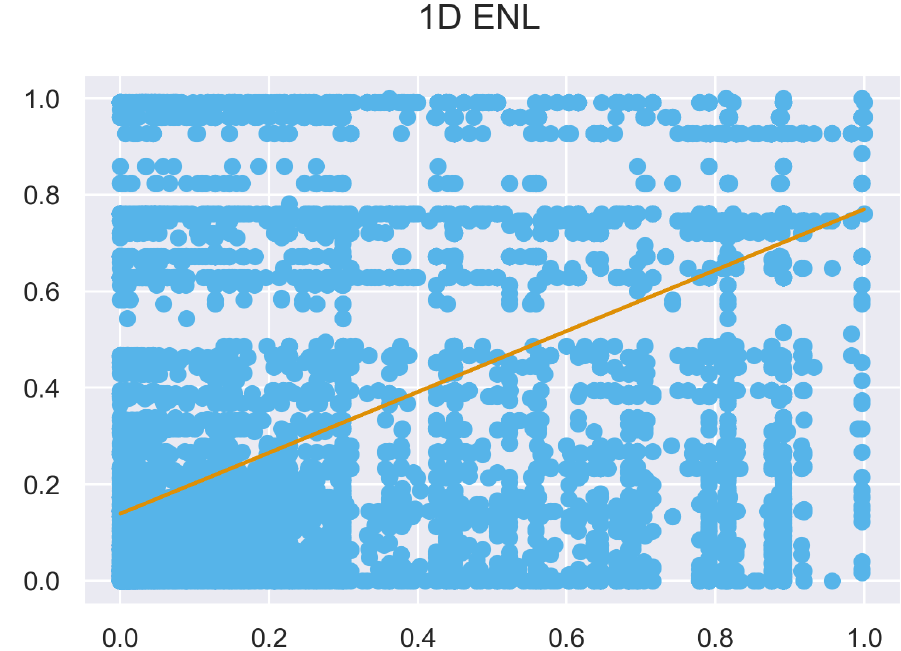
Figure A5. ULS and TLS 1 D ENL regression at 0.5 m grid size.